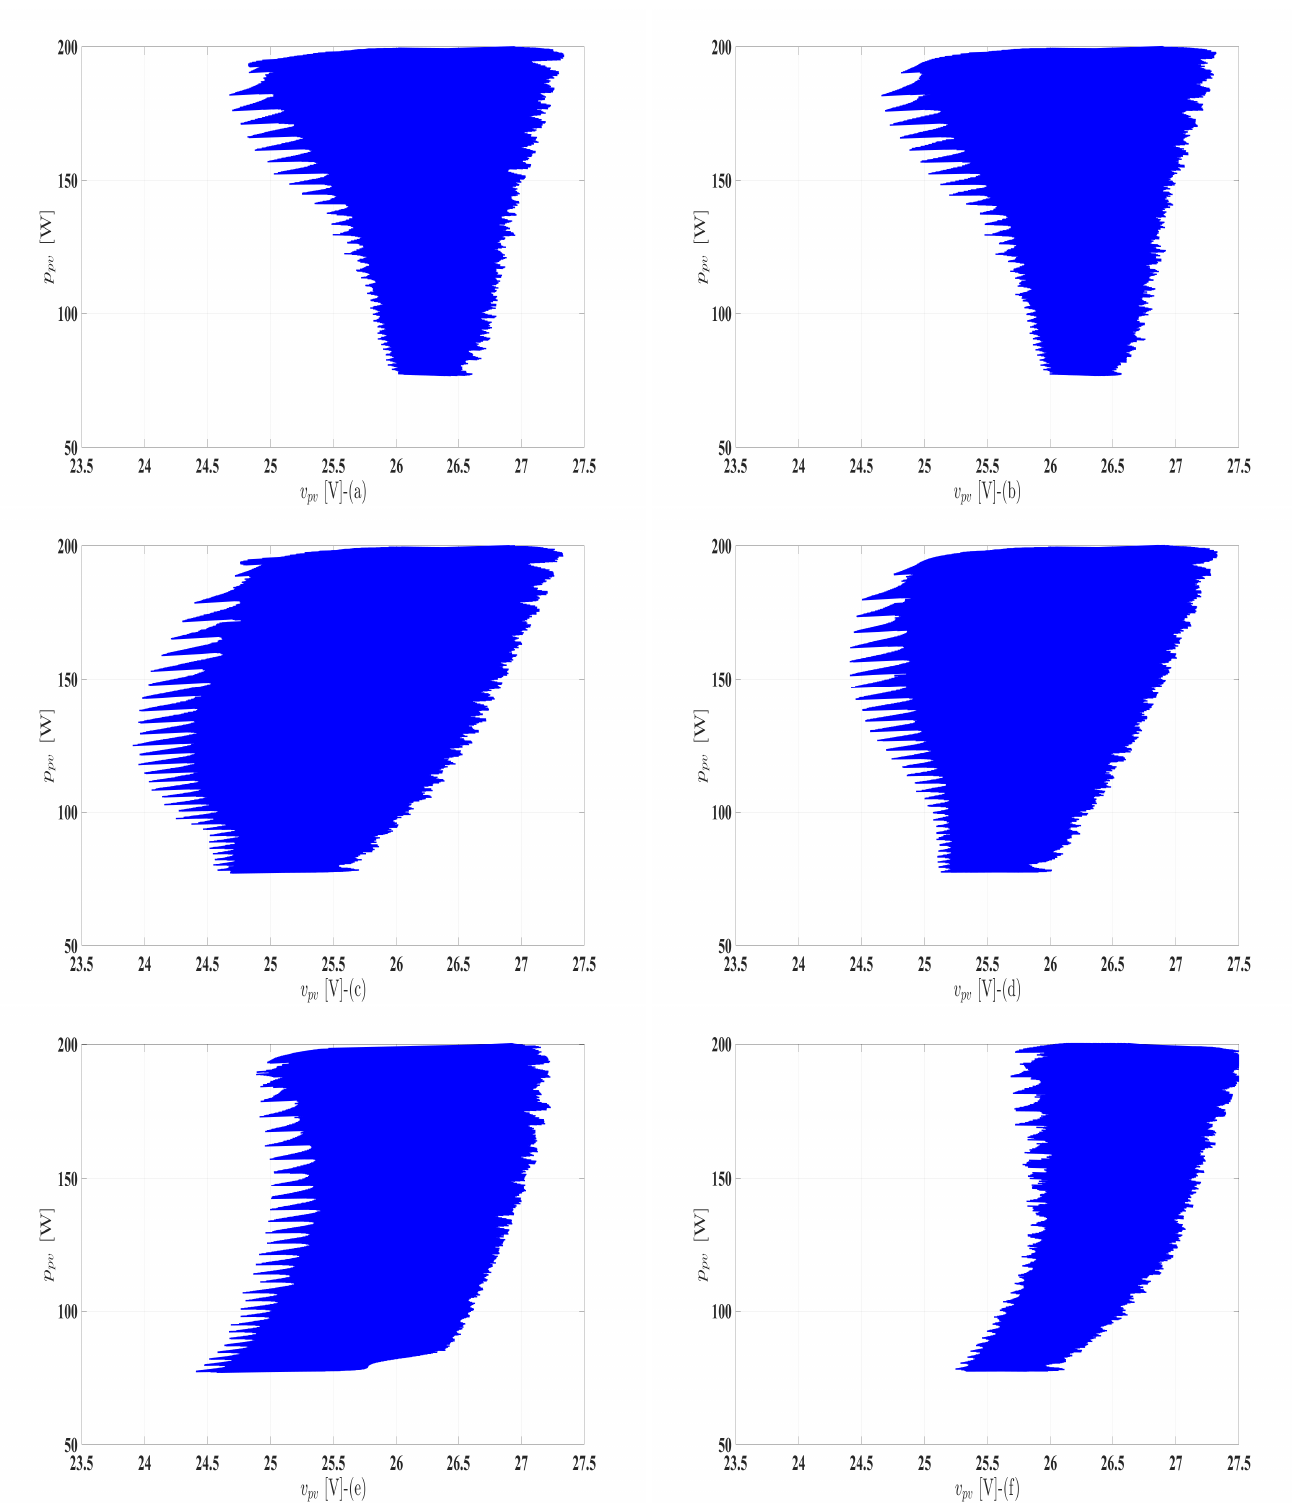
Figure 8. The power-voltage response of model-based MPPT methods at dynamic variation of radiation. ( a ) Constant voltage method, ( b ) temperature method, ( c ) voltage-based method (V1), ( d ) voltage-based technique (V2), ( e ) current-based algorithm, ( f ) curve fitting